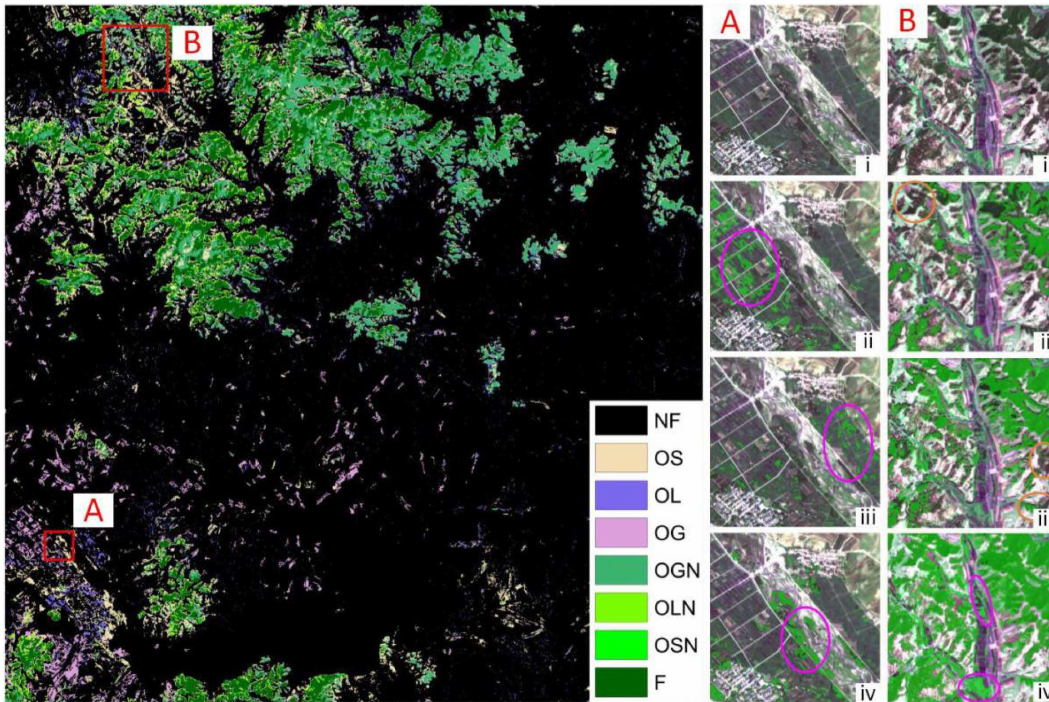
Figure 8. Classification results of images from different sensors in area